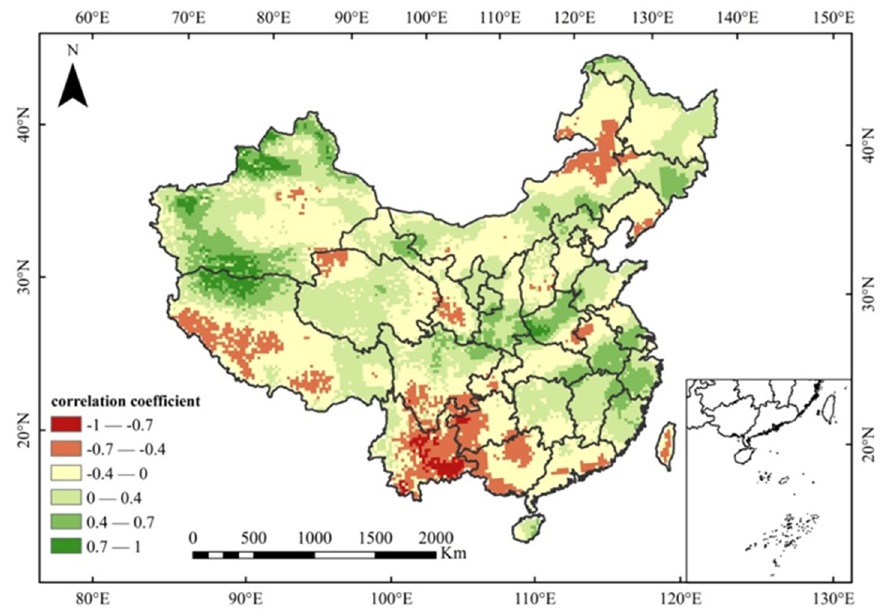
Figure 10. Correlation between annual TCO concentration and precipitation.